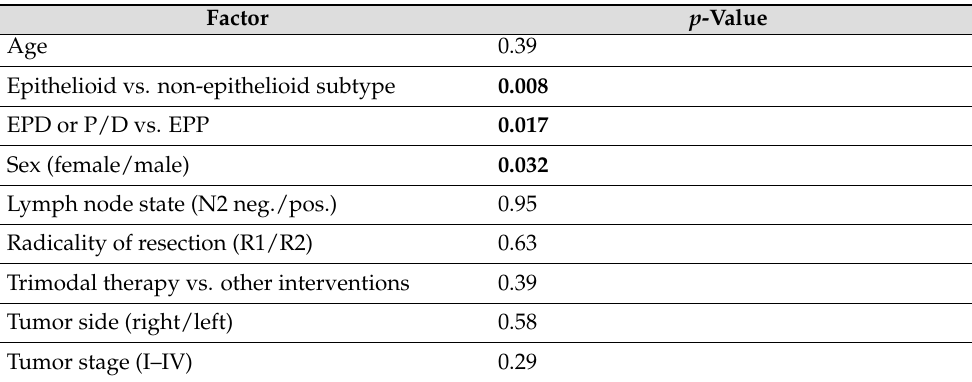
Table 6. Factors of possible prognostic significance in surgically treated patients. Statistically signifi- cant p -values were printed in bold.